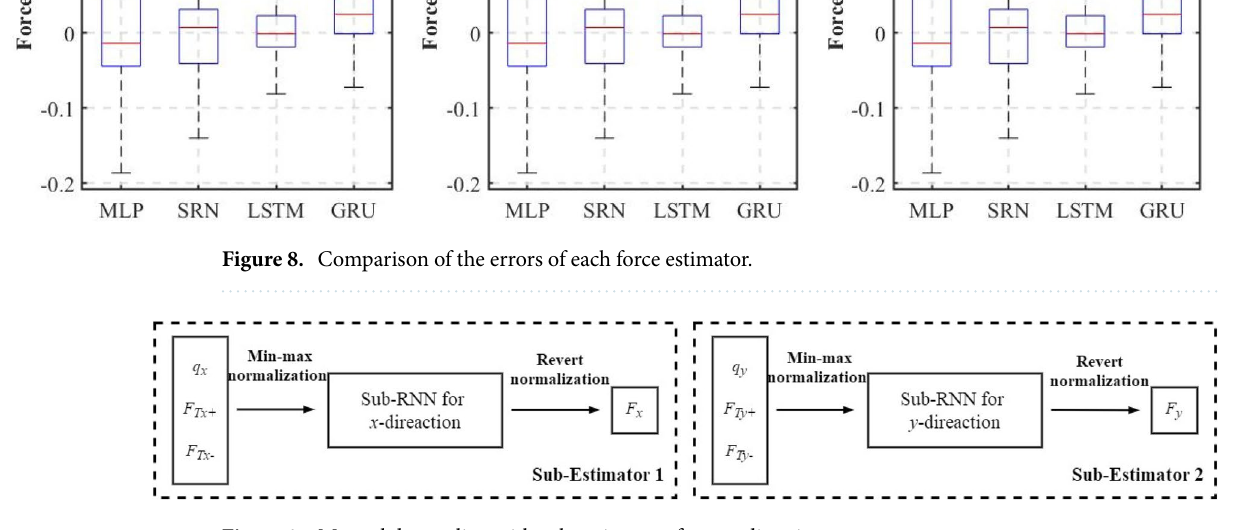
Figure 9. Manual decoupling with sub-estimators for two